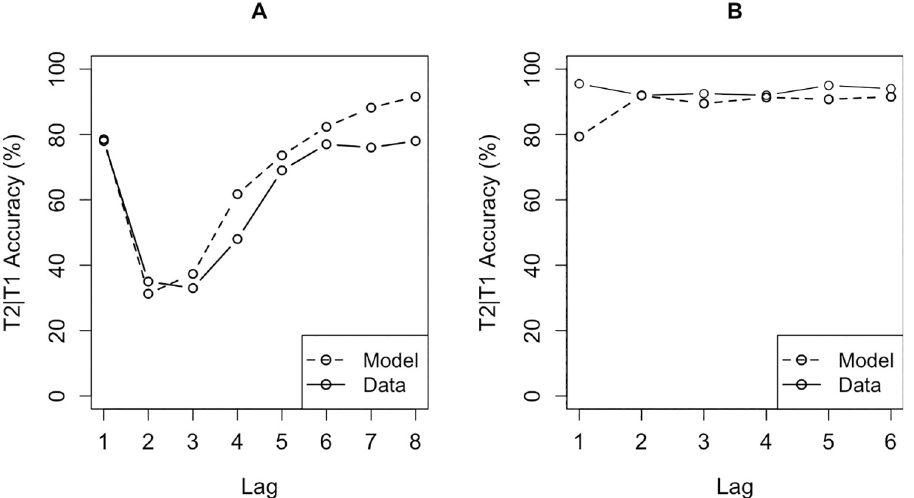
Fig 1. Model fits for both versions of the AB model. (a) the fit of the “consolidate-separate” model with data reported in a classic AB study [30]. (b) the fit of the “consolidate-chunked” version of the AB model with the data reported in the study by Ferlazzo and colleagues